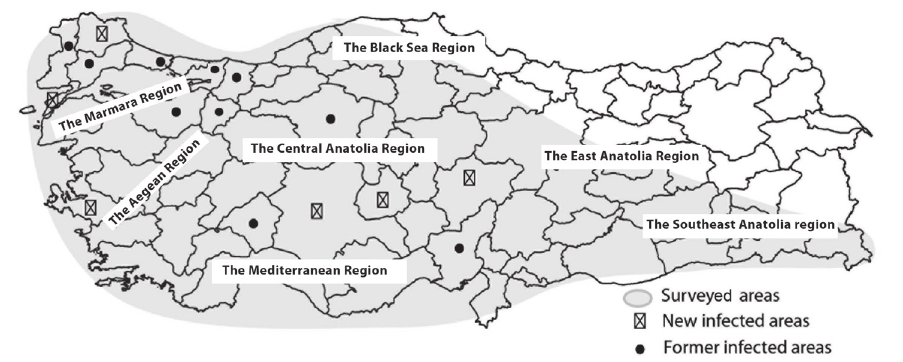
Figure 1. Surveyed areas infected with Plum pox virus